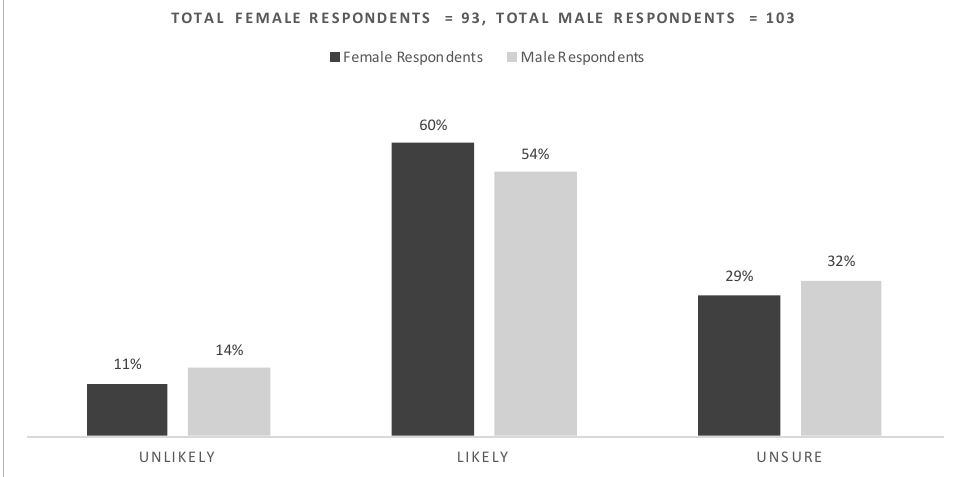
Figure 5. Likelihood that youth will move away from their community.